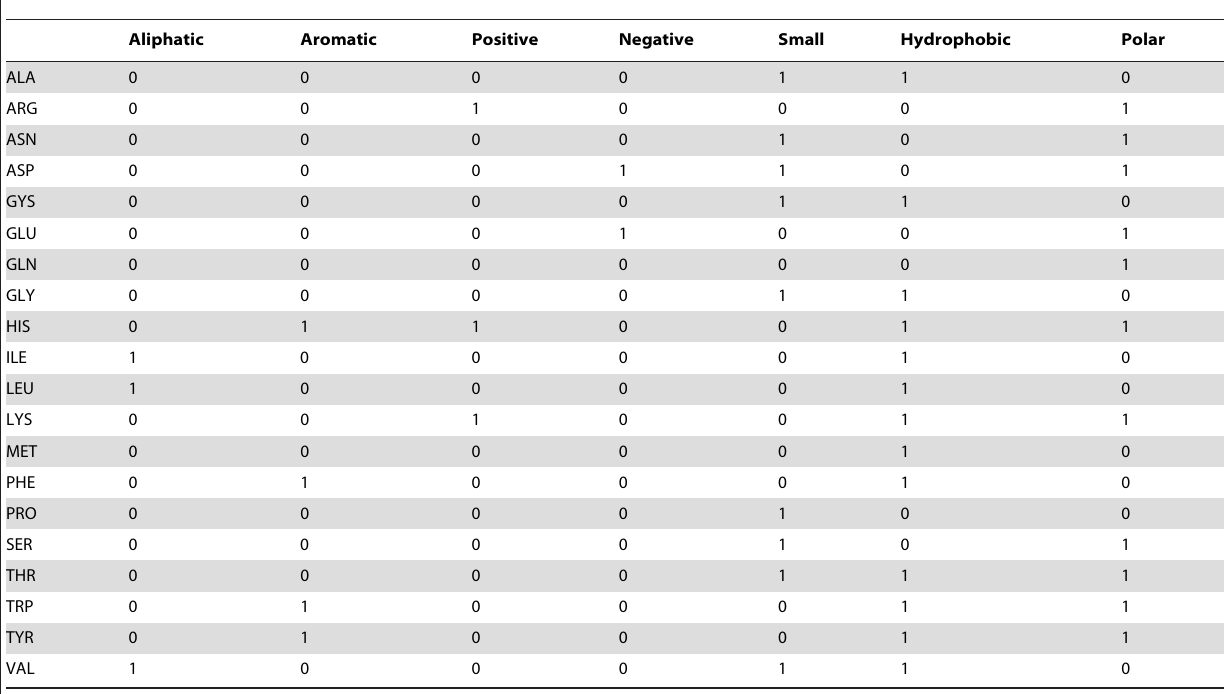
Table 2. Amino acid residue classes according to their physicochemical properties.